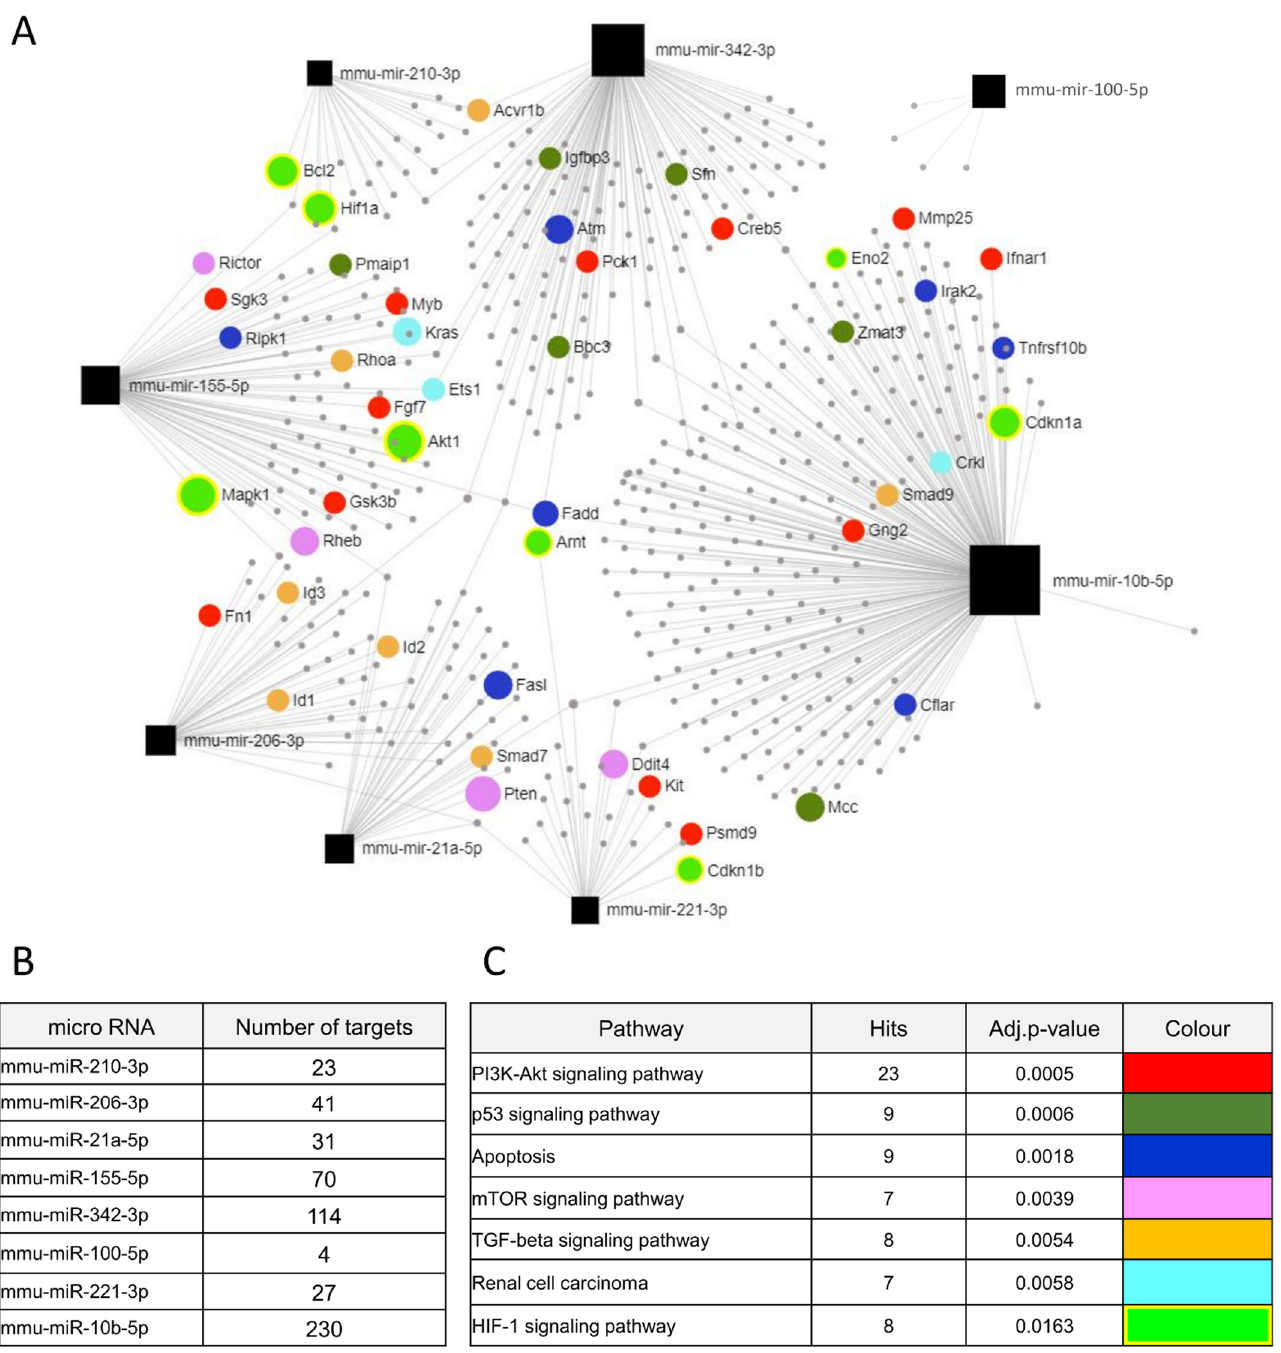
Figure 6. The predicted target genes of DEmiRNAs ( A ) Network of target gene, with marked genes involved in potentially dysregulated signaling pathways, predicted using the miRNET software ( B ) Number of target genes for each DEmiRNA ( C ) Potentially deregulated signalling pathways for predicted target genes analyzed through susceptibility genes enrichment.